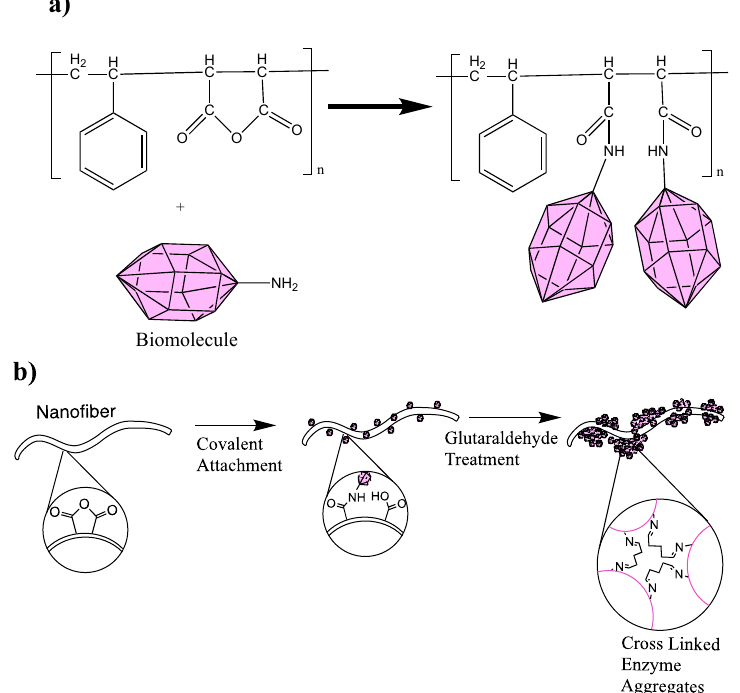
Figure 5. ( a ) Schematic of covalent attachment of biomolecules onto maleic anhydride functional group; ( b ) Covalent attachment of enzymes and enzyme aggregate coating [56]. Redrawn according to Smith et al.